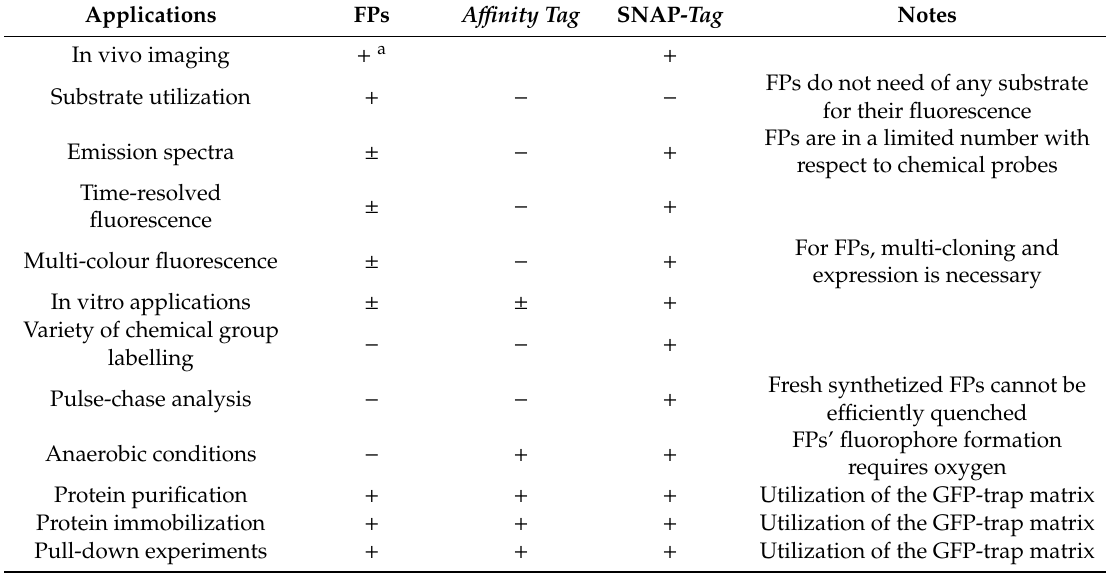
Table 1. The use of protein tags in some applicative